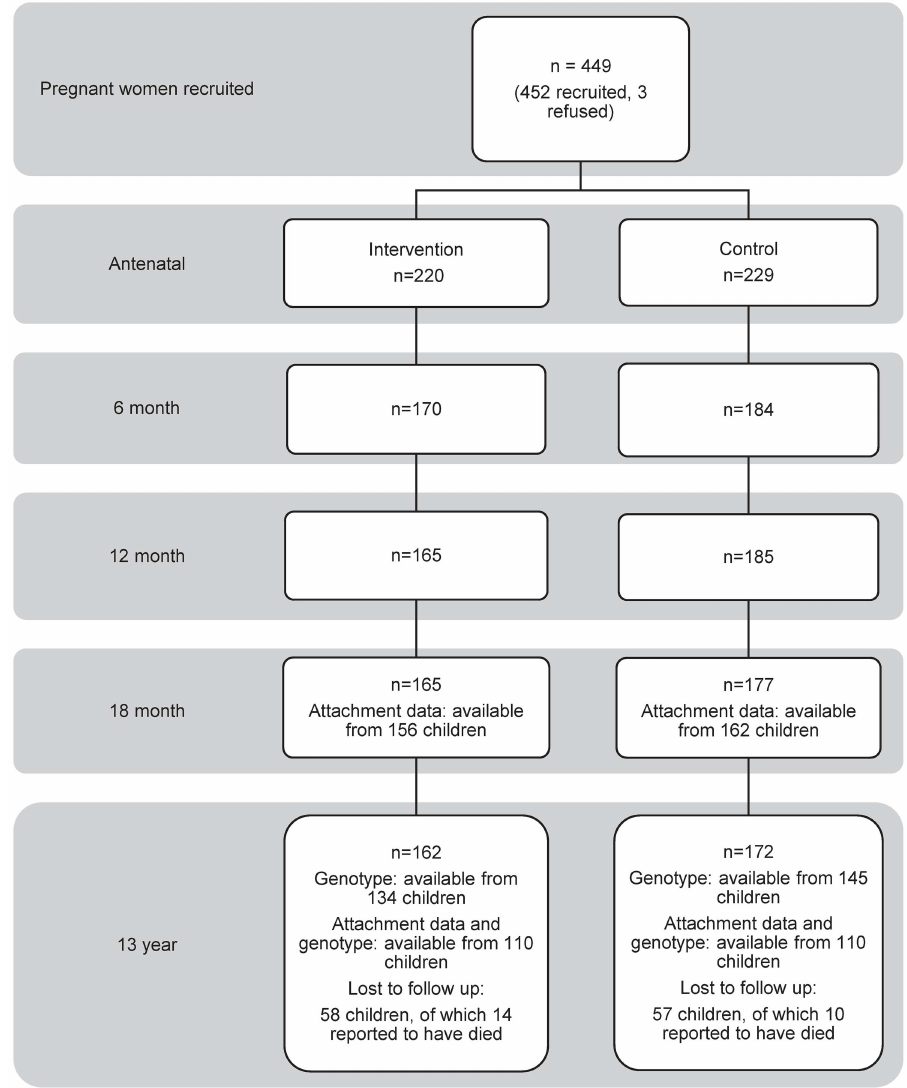
Fig 1. Flowchart showing how the sample of 220 13-y-old children with both 5HTTLPR genotype and attachment security data was assembled for this study.